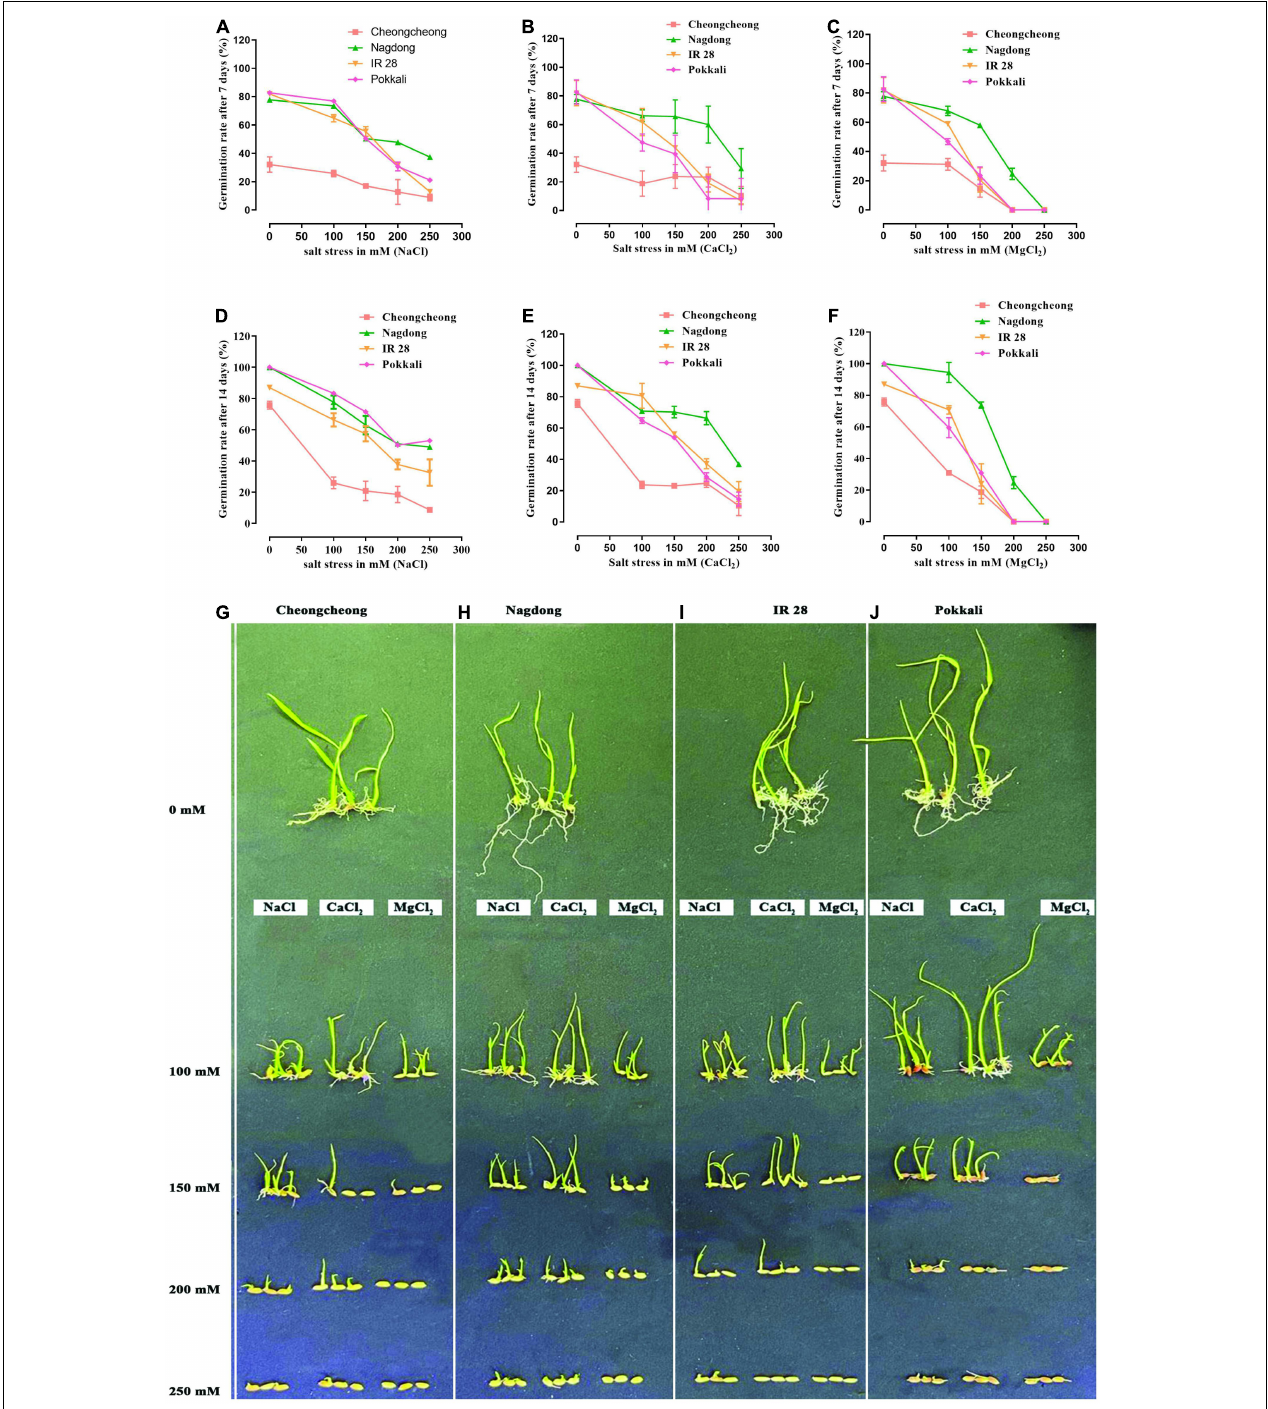
FIGURE 1 | Seed germination test among rice genotypes under different salt stress. Different concentrations of different salts (NaCl, CaCl 2 , and MgCl 2 ) were used to evaluate the seed germination and seedling growth (A–J) .